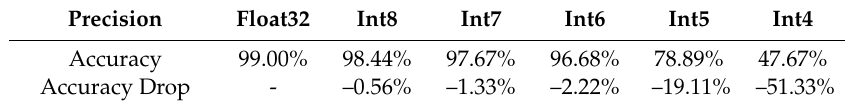
Table 2. Precision of the integer ‐ quantized WBC classification network compared with floating point.